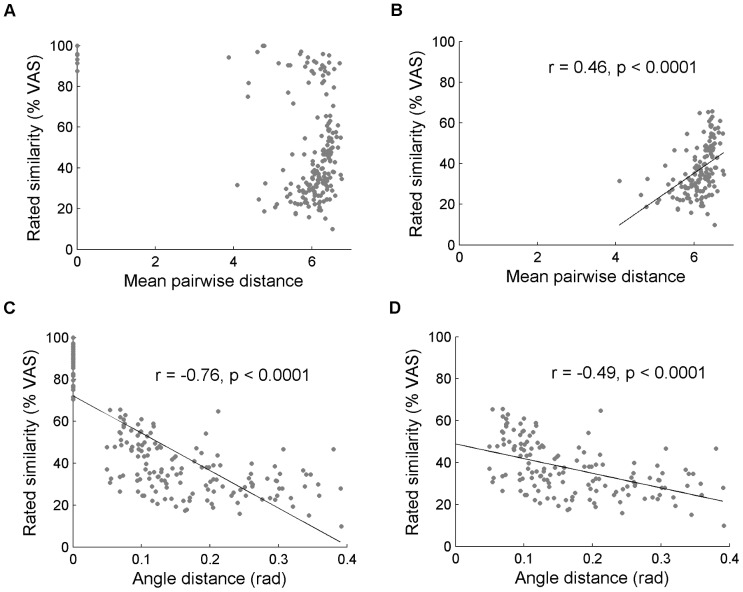
Performance of the pairwise distance and angle distance models.Each dot reflects a comparison between two odorant mixtures. (A) The pairwise distance model was not predictive of mixture similarity. (B) Removing comparisons of a mixture to itself, the pairwise distance model implies a non-logical point from which increases in structural similarity drive decreases in perceived similarity. (C) The angle distance model provides a strong prediction of perceived similarity. (D) The angle distance model continues to provide logical results after removing comparisons of mixtures to themselves.